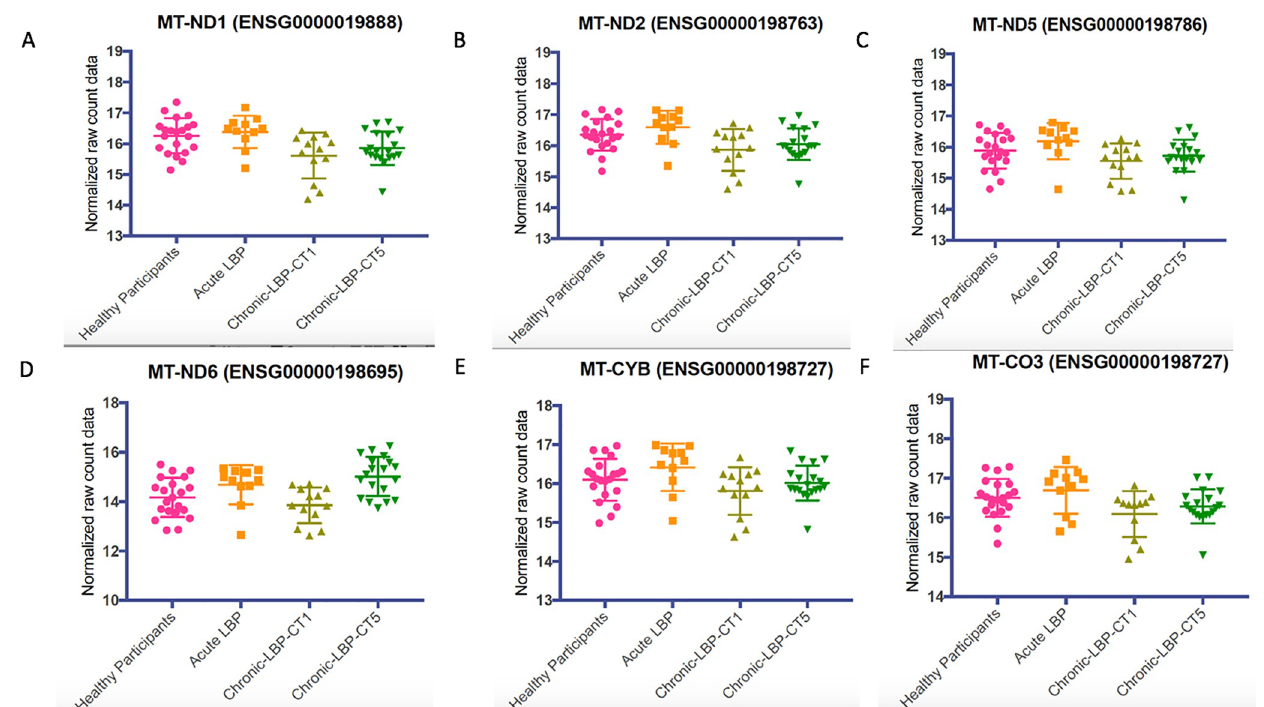
Fig 6. The whole blood gene expression levels for a cluster of mitochondrial genes associated with oxidative phosphorylation from String 10 protein- protein interaction analysis were plotted. Results demonstrate that levels of each gene are differentially lower in the chronic T1 compared with the acute and normal participants. In each panel, the raw, normalized, non-zero gene expression counts from DESeq analysis are displayed as a scatter plot for each cohort. Symbols indicate individual expression levels for each of the N = 64 samples. A Kruskal-Wallis 1-way ANOVA was used to examine comparisons. In all cases except MT-CYB , the expression levels were statistically significantly lower in chronic T1 patients. (A) Mitochondrial encoded NADH dehydrogenase 1 ( MT-ND1 ) gene (H = 12.29, p = 0.0064. (B) NADH dehydrogenase 2 ( MT-ND2 ) gene (H = 12.05, p = 0.0072). (C) NADH dehydrogenase 5 ( MT-ND5 ) gene (H = 10.22, p = 0.0168). (D) NADH dehydrogenase 6 ( MT-ND6 ) gene (H = 17.03, p = 0.0007). (E) Cytochrome B ( MT-CYB ) gene (H = 7.333, p = 0.0620). (F) Cytochrome C oxidase III ( MT-CO3 ) gene (H = 8.146, p = 0.0431).